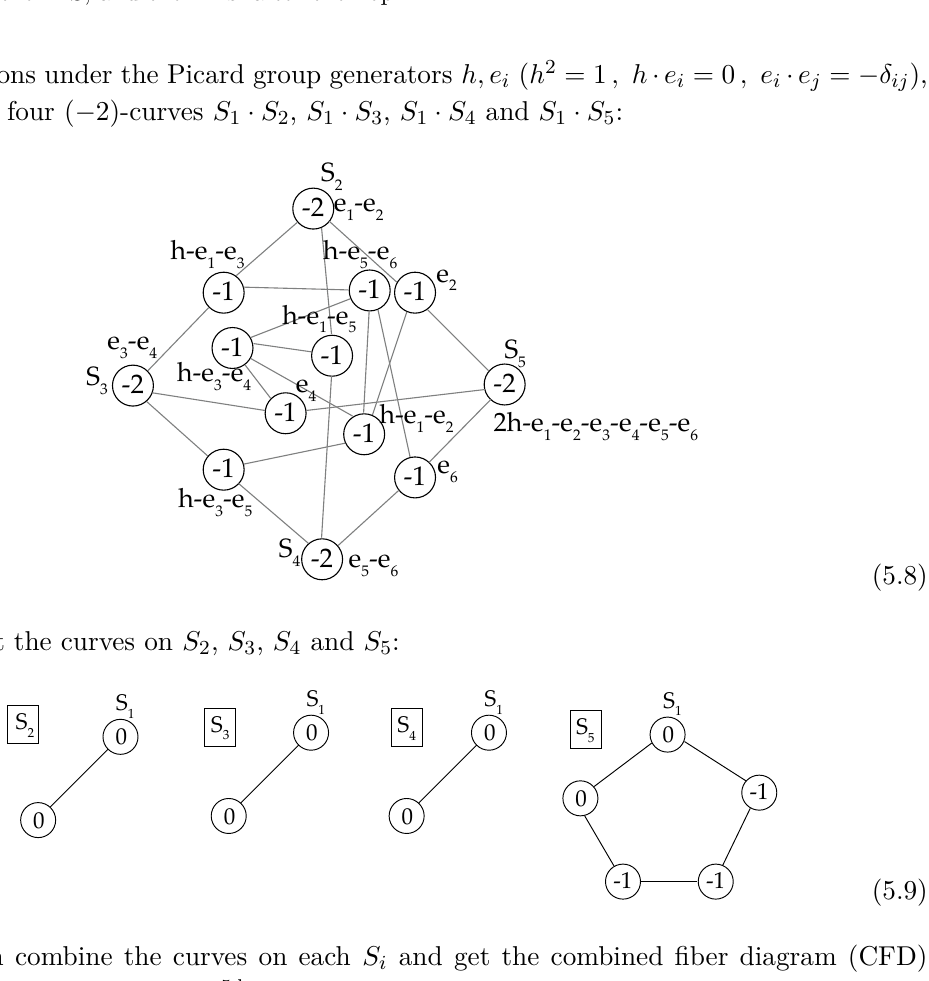
Figure 1 . Resolved AD [ E 7 , E 7 ] geometry: compact surfaces are S i and gluing curves are links between these, with self-intersection numbers shown in the boxes. The l.h.s. is the model after resolution of the IHS, and the r.h.s. after the